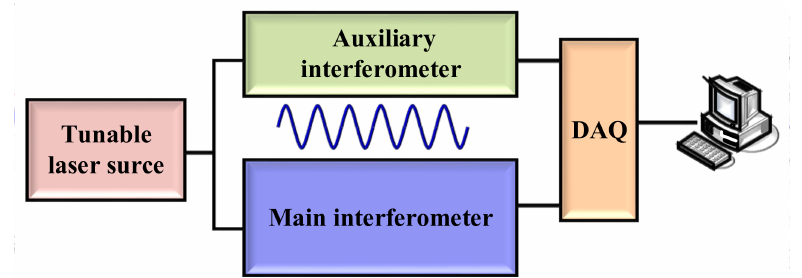
Figure 4. Software algorithms for compensation of the nonlinear phase noise in OFDR. DAQ is a data acquisition card.